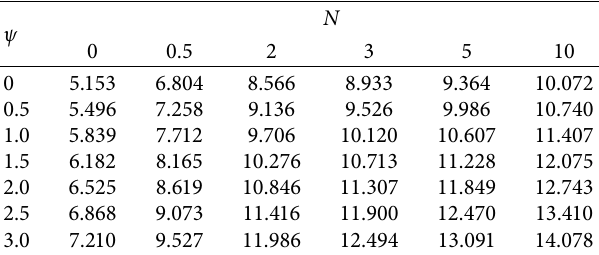
Table 7: The deflection | w ∗ | nanoplate, a / h � 10, and a / b � 1.